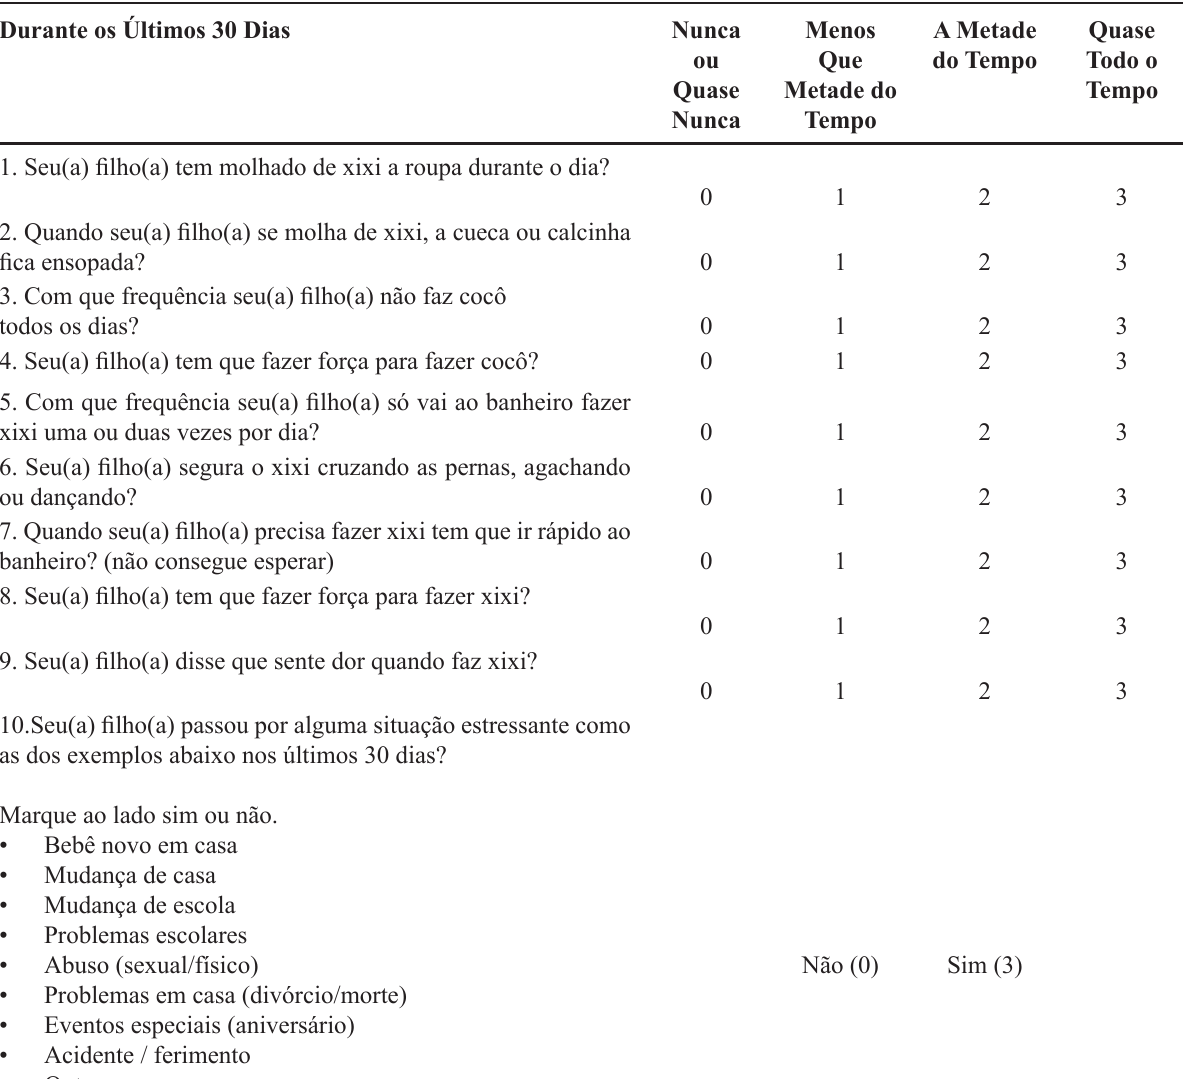
Menos A Metade Quase ou Que do Tempo Todo o Quase Metade do Nunca Tempo